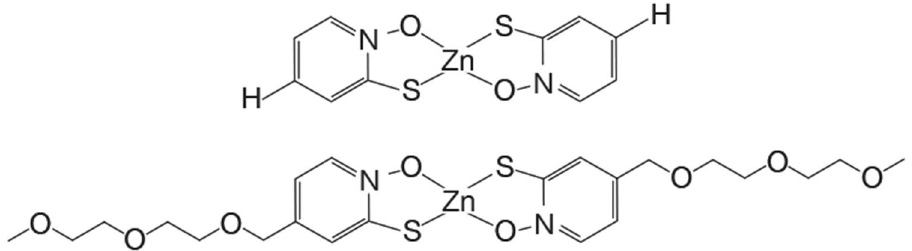
Figure 1. Zn5002 and ZnPT complexes chemical structures. Chemical structures of ZnPT (upper) and Zn5002